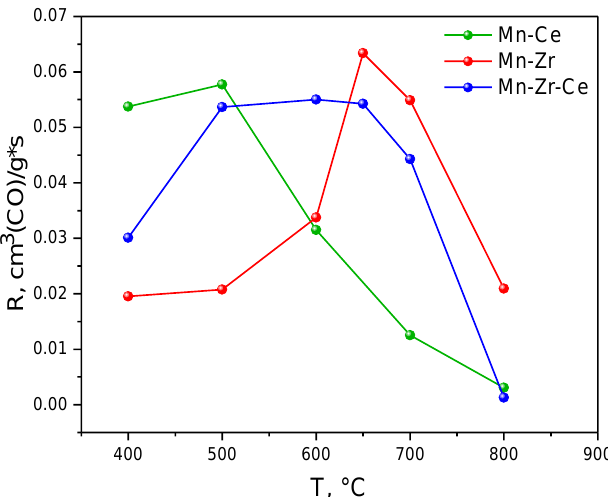
Figure 1. Catalytic activity of Mn-Ce, Mn-Zr and Mn-Zr-Ce samples, calcined at different tempera- tures, in CO oxidation at 150 °C.